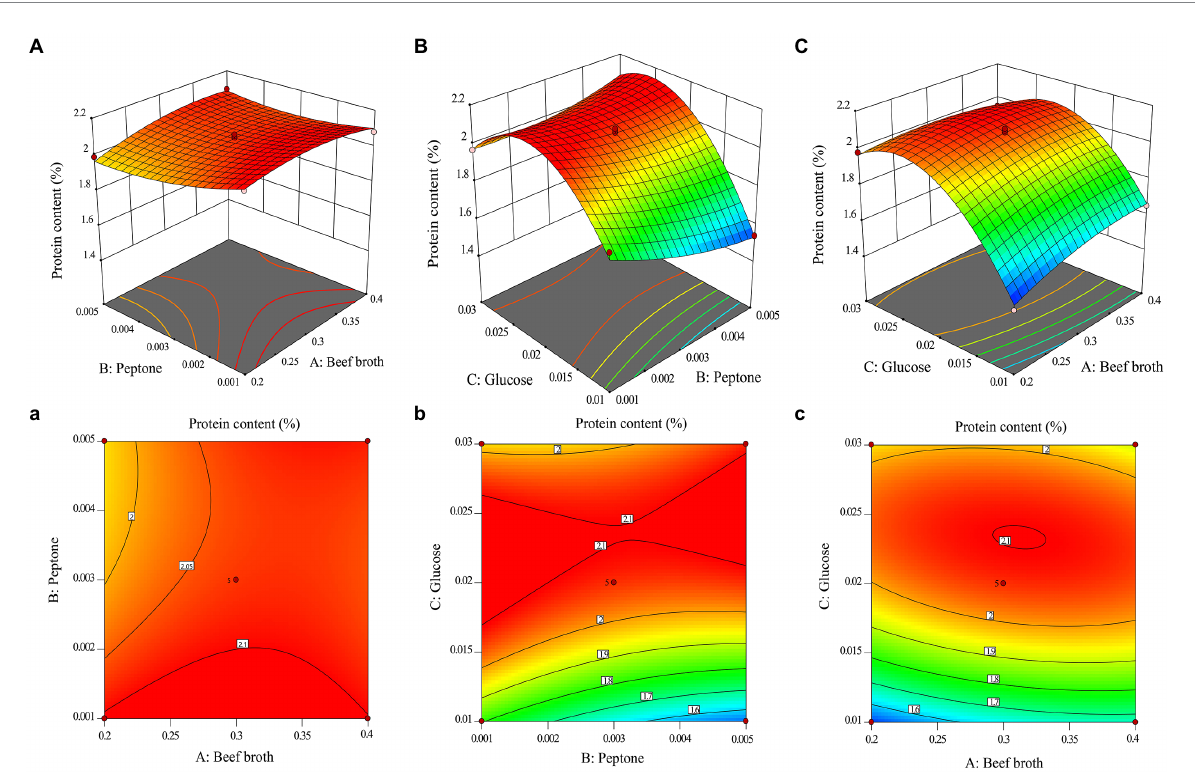
FIGURE 1 3D response surface and corresponding contour line of mycelial protein content: (A) Effect of beef broth and peptone addition on mycelial protein content; (B) Effect of peptone and glucose addition on mycelial protein content; (C) Effect of beef broth and glucose addition on mycelial protein